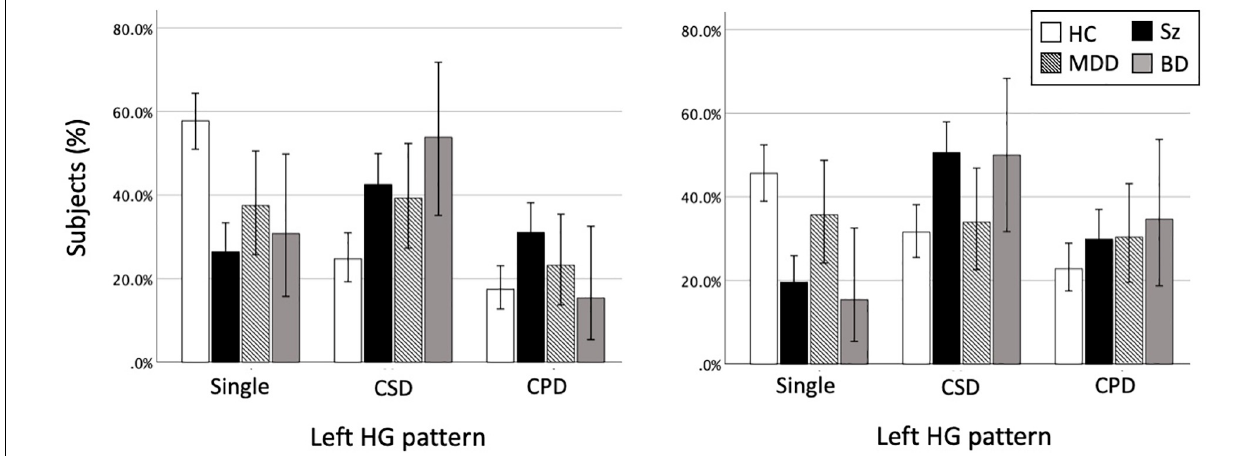
FIGURE 2 | Heschl’s gyrus (HG) gyrification patterns in healthy controls (HC), schizophrenia (Sz), major depressive disorder (MDD), and bipolar disorder (BD). The present study examined the HG patterns in MDD and BD cohorts, but the data of 174 patients with Sz (Takahashi et al., 2021a,b,c) are also presented here for the purpose of comparison. The results of the HC group ( N = 206) reflect all data from the present and our previous (Takahashi et al., 2021a,b,c) studies. Direct comparisons between the disorders showed that the MDD patients had a lower prevalence of right HG duplication compared to Sz ( χ 2 = 6.17, p = 0.013) and BD ( χ 2 = 3.55, p = 0.060) patients. However, there was no group difference between the BD and Sz. Error bars show 95% confidence intervals. CPD, complete posterior duplication; CSD, common stem